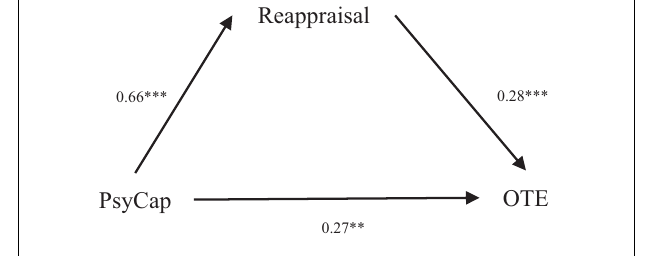
FIGURE 1 | The mediating model of Psychological Capital (PsyCap), reappraisal, and online teaching enjoyment. *** p < 0.001; ** p <